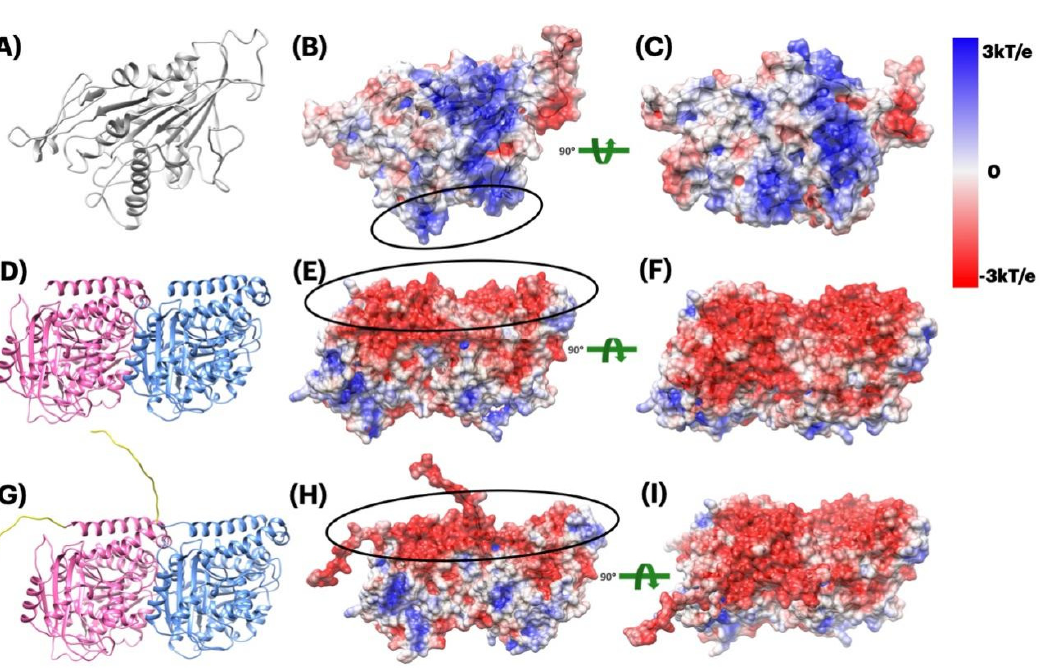
Figure 3. Electrostatic potential colored on the surface of kinesin and tubulins dimer. ( A ) Kinesin structure; ( B ) Electrostatic potential on the surface of kinesin (front view); ( C ) Electrostatic potential on the surface of kinesin (bottom view, interfacial side); ( D ) Tubulins dimer structure without E-hooks; ( E ) Electrostatic potential on the surface of tubulin dimer without E-hooks (front view); ( F ) Electrostatic potential on the surface of tubulin dimer without E-hooks (top view, interfacial side); ( G ) Tubulins dimer structure with E-hooks (yellow tails); ( H ) Electrostatic potential on the surface of tubulin dimer with E-hooks (front view); ( I ) Electrostatic potential on the surface of tubulin dimer with E-hooks (top view, interfacial side). Color scale: − 3.0 to 3.0 kT/e (red to blue).